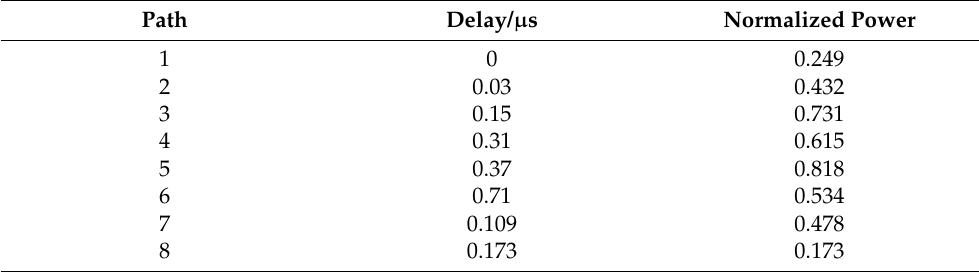
Table 2. Parameters of channel EVA.